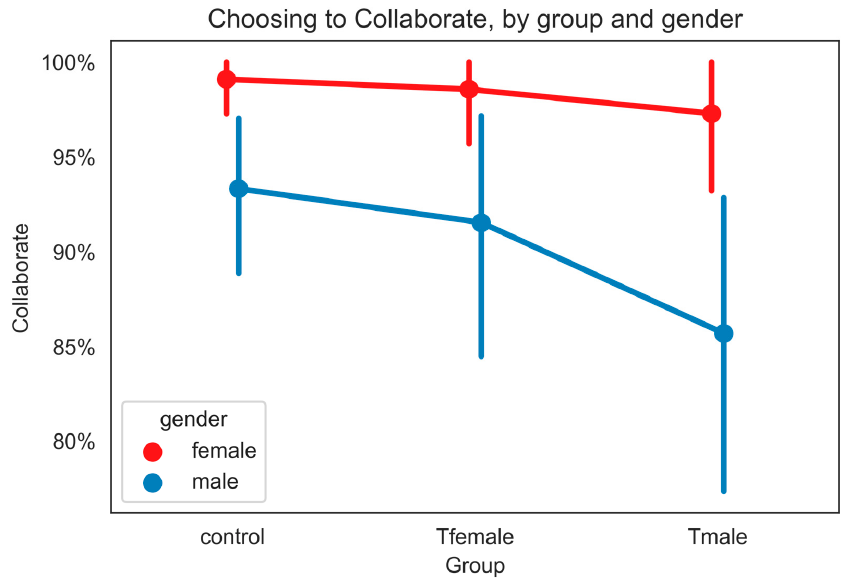
Figure 1. Percentage and standard errors for workers choosing to collaborate (“work together” strat- egy), by treatment and gender. Gender differences are statistically significant in each experimental condition (Fisher’s exact